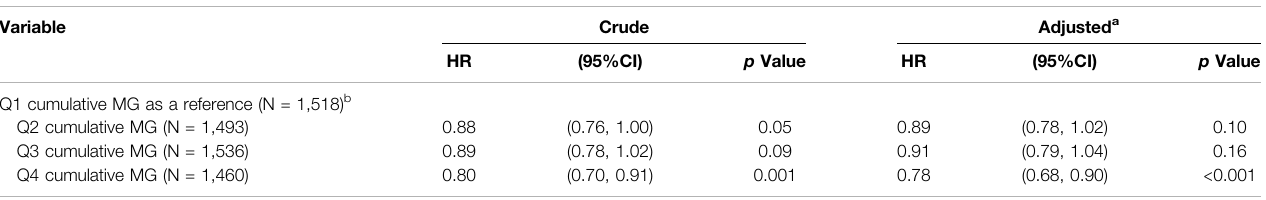
TABLE 5 | Hazard ratio and 95% con fi dence interval of type 2 diabetes associated with cumulative doses of benzbromarone use.